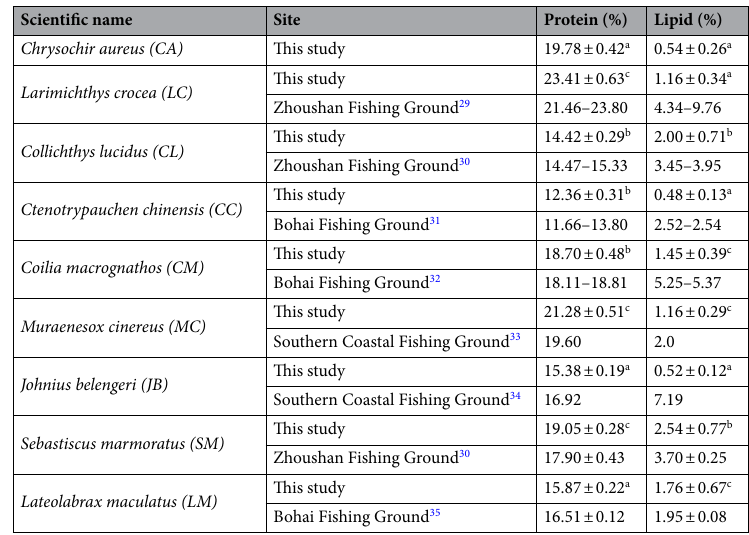
Table 2. The chemical in the fish muscles of nine fish species collected from Dachen fishing ground. Values in the same column having different superscript letters are significantly different(P < 0.05).